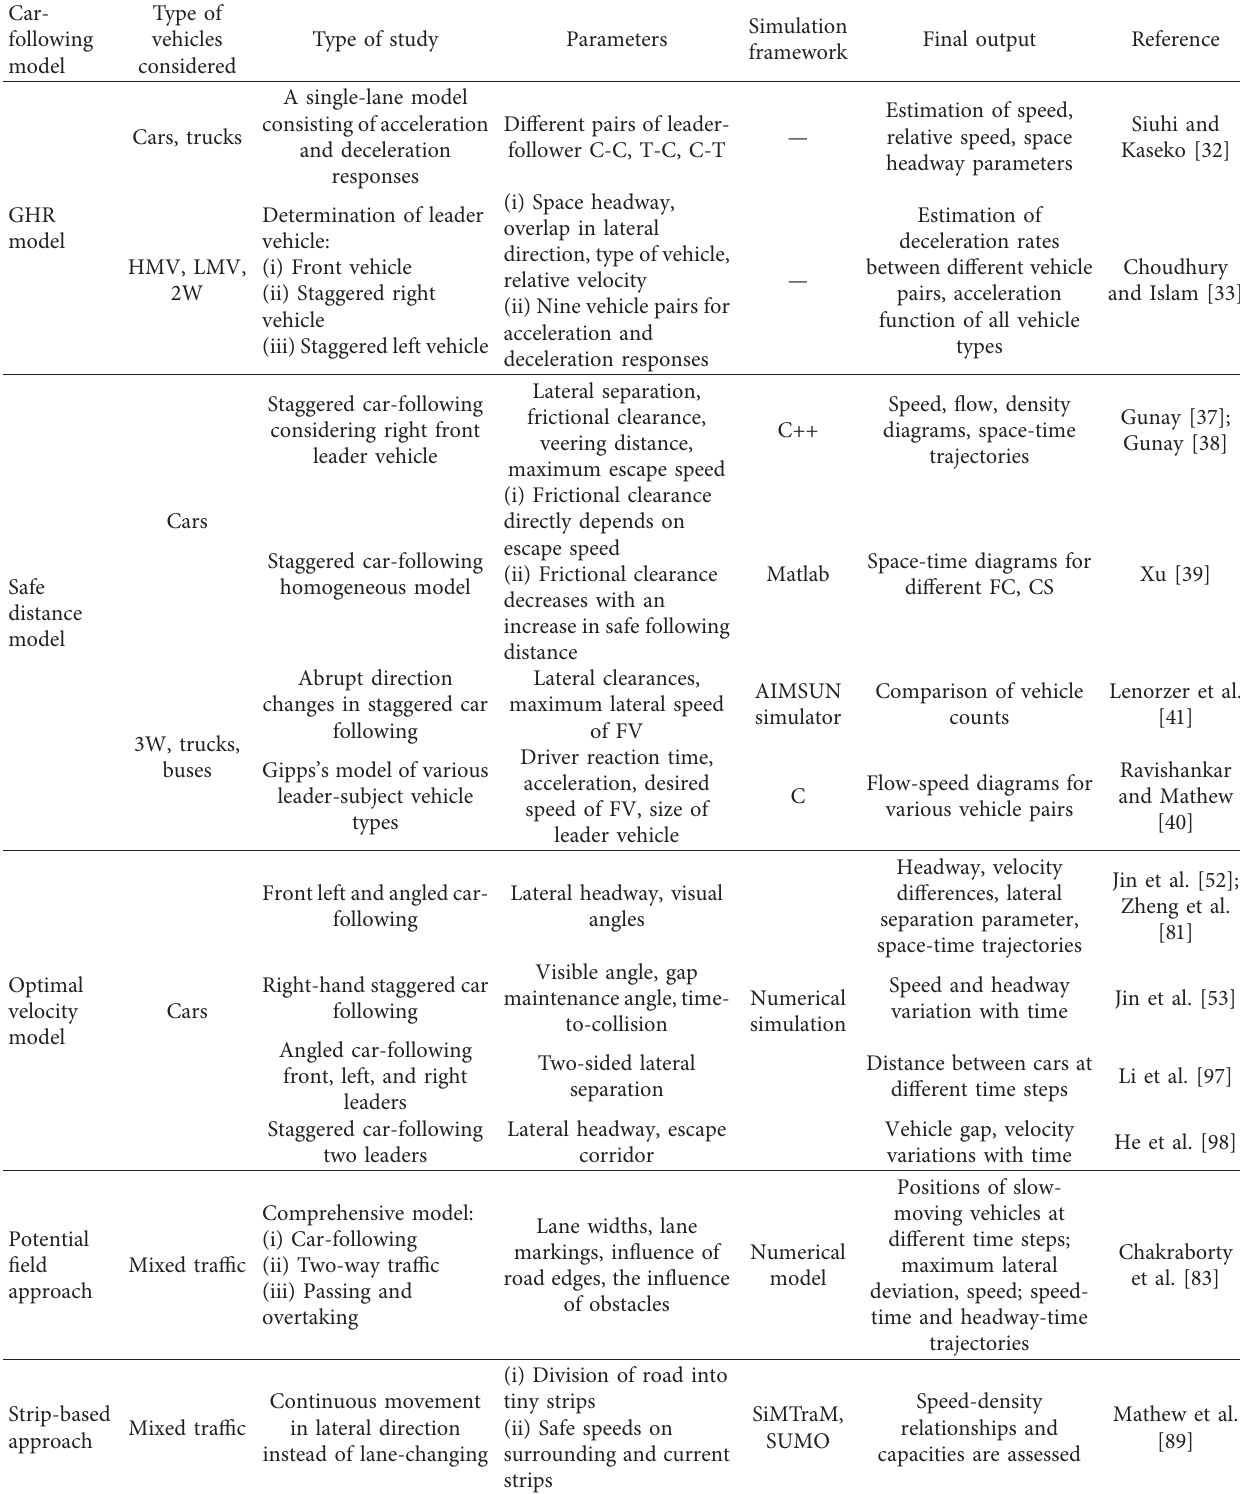
Table 3: Outline of car-following